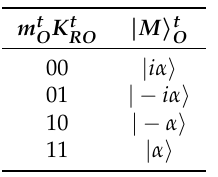
K t and | M (cid:105) t P RP P